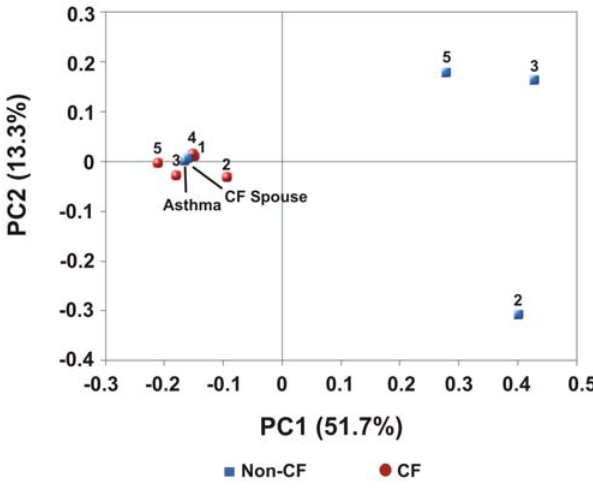
Figure 2. Principal components analysis (PCA) of respiratory tract viromes based on phage taxonomic composition. Non-CF metagenomes are shown in blue and CF metagenomes are shown in red. Inputs to PCA were normalized percentages of best tBLASTx hits to completely sequenced phage genomes. Non-CF1Asthma and Non- CF4Spouse cluster with the CF